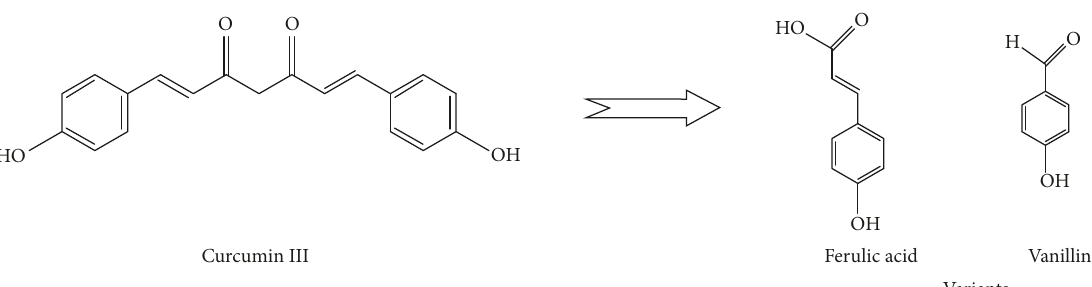
Figure 5: Bisdesmethoxycurcumin’s (curcumin III) nonenzymatic degradation